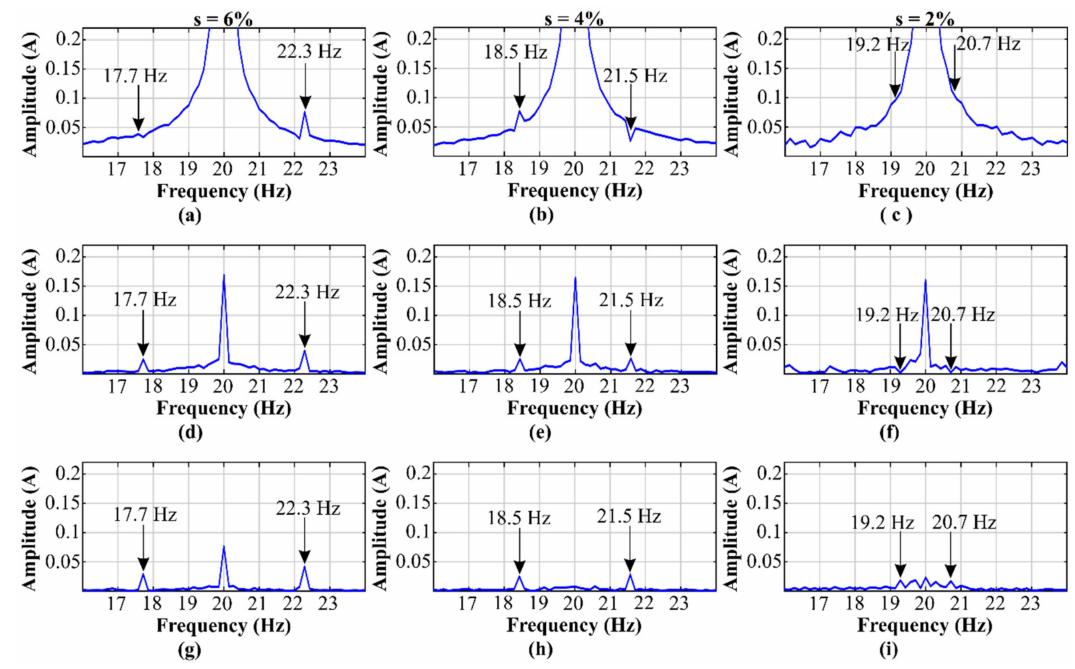
Figure 5. Spectrum for the motor current operating at 20 Hz using ( a ) MCSA at high load, ( b ) MCSA at medium load, ( c ) MCSA at low load, ( d ) NF-MCSA at high load, ( e ) NF-MCSA at medium load, ( f ) NF-MCSA at low load, ( g ) GA-MCSA at high load, ( h ) GA-MCSA at medium load, and ( i ) GA-MCSA at low